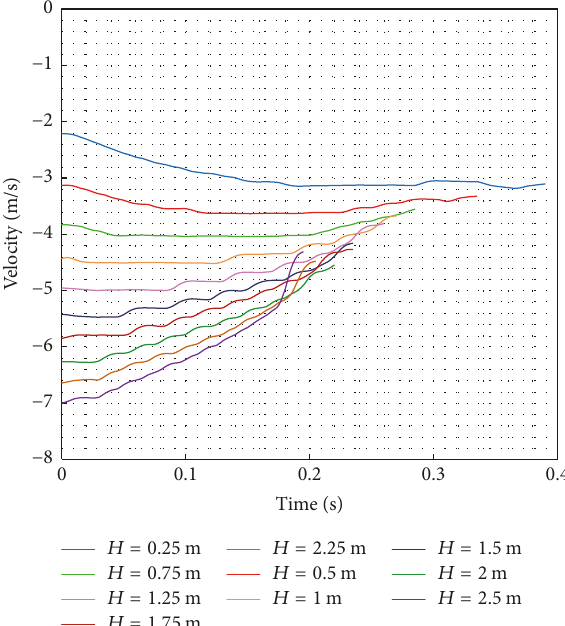
Figure14:Velocity-timegraphoftheconicalpounderwithdifferent drop heights.